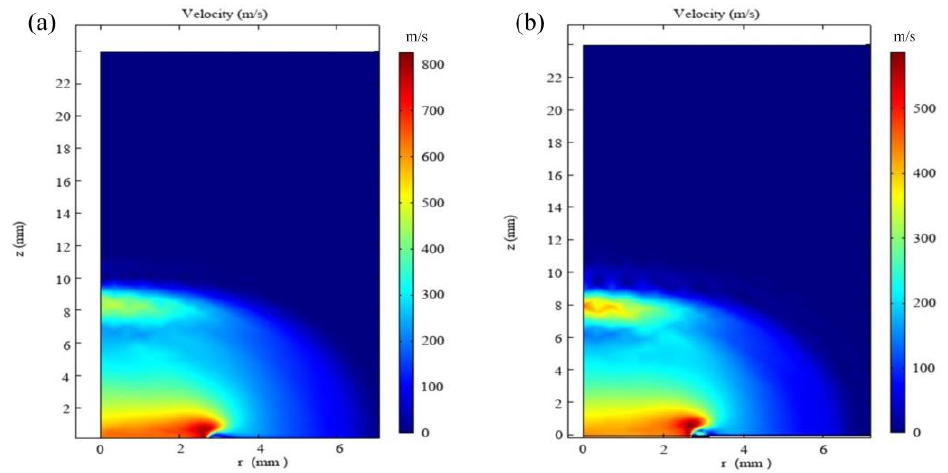
Figure 6. The spatial distribution of shock wave velocity ( a ) in case 1 at 807 μs and ( b ) in case 2 at 2407 μs .